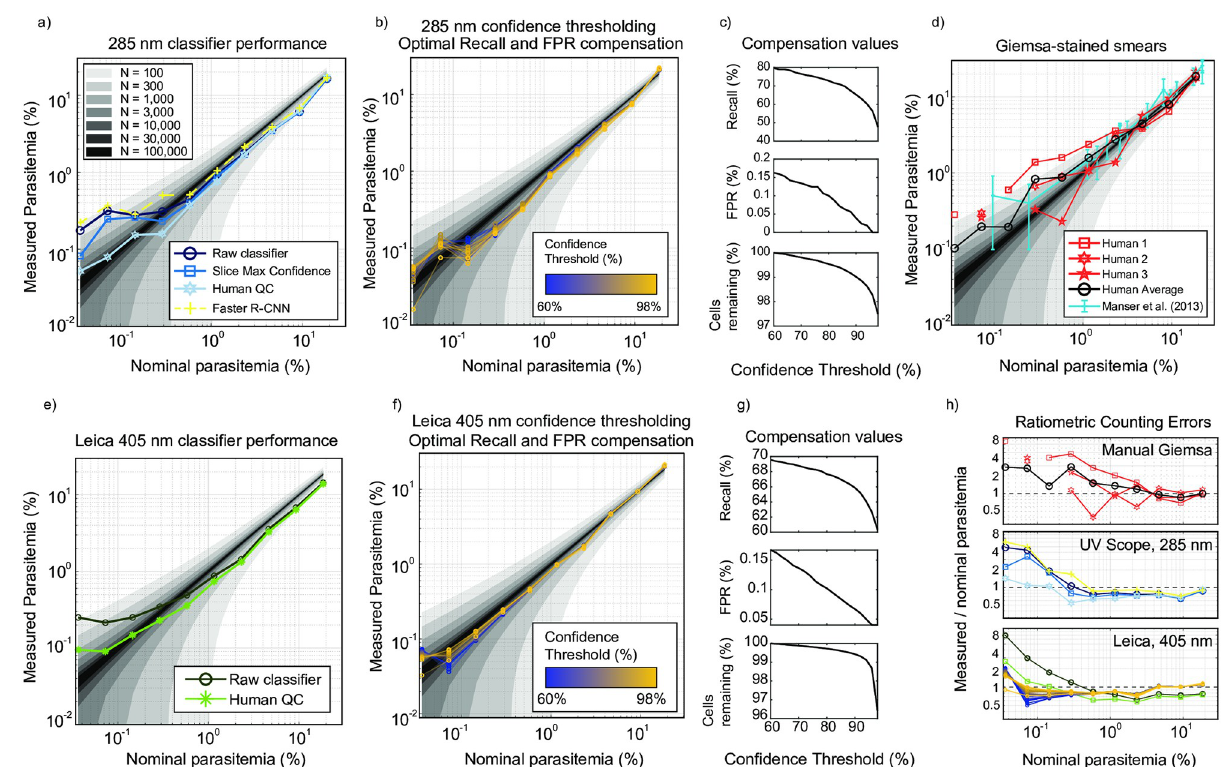
Fig 8. Parasitemia titration results. Logscale plots a-b,d-f contain shaded regions corresponding to nominal mean parasitemia plus or minus one standard deviation of the underlying Poisson distribution when counting N total cells, where N is varied from 100 up to 100,000 in roughly 3 × increments. The nominal parasitemia in panels a-b,d-f is derived from a manual count of the titration high point using 2,214 total cells, with all remaining nominal diluted values computed by theoretical dilution factor. a) Sample parasitemia extracted from the raw 285 nm classifier results is plotted in dark blue. Post-processing using the maximum slice confidence technique is shown in blue, resulting in a reduction of the false-positive rate evidenced by a further drop in the lowest points of the curve. The light blue data show the result of human collaboration on the putative infected and lowest-confidence healthy cells. The Faster R-CNN method was used to detect cells directly on the raw images (yellow). b) The data from a) were re- plotted after compensation for recall and FPR, for an array of confidence threshold values applied to the data. c) Recall and FPR compensation values are plotted as a function of confidence threshold, which both decrease with threshold value, as healthy cells’ median confidence is on the order of 99.9%. d) Manual counting of Giemsa-stained smears by three experienced technicians are plotted with solid red curves (human 1: squares, human 2: hexagrams, human 3: pentagrams), and their arithmetic mean plotted in solid black (circles). Missing markers correspond to points where no parasites were located in the 300 cell sample. Blue data with error bars represents the data from Table 2 in [8], showing the result of extensive validation across hundreds of trained microscopists. Error bars indicate standard deviation across participants’ parasitemia estimations. The “Reference mean parasitemia” column from the cited table was used as x-values during overlay. e) The titration results were plotted for the classifier trained on commercial microscope at 405 nm. Dark green circles: raw classifier results, Green ‘+’ signs: Compensated classifier results, and light green ‘ � ’: after human collaboration, as described in a). f) Commercial microscope classifier results after compensation, for various confidence threshold values. Large cell count numbers permit low relative counting variance, reducing deviation from the underlying distribution. g) Compensation values for recall (top), FPR (middle), and remaining cells after thresholding (bottom) from the data in f). h) Ratiometric error of the data in panels a,b,d,e, and f) vs. nominal parasitemia. Top: Manual counting of Giemsa-stained smears (d), middle: UV Scope classifier at 285 nm (a,b), and bottom: Commercial microscope images at 405 nm (e,f). All data in h) are referenced to the legends in their corresponding raw data panels. All titration data was purely ‘test data’, acquired after classifier training and validation had been